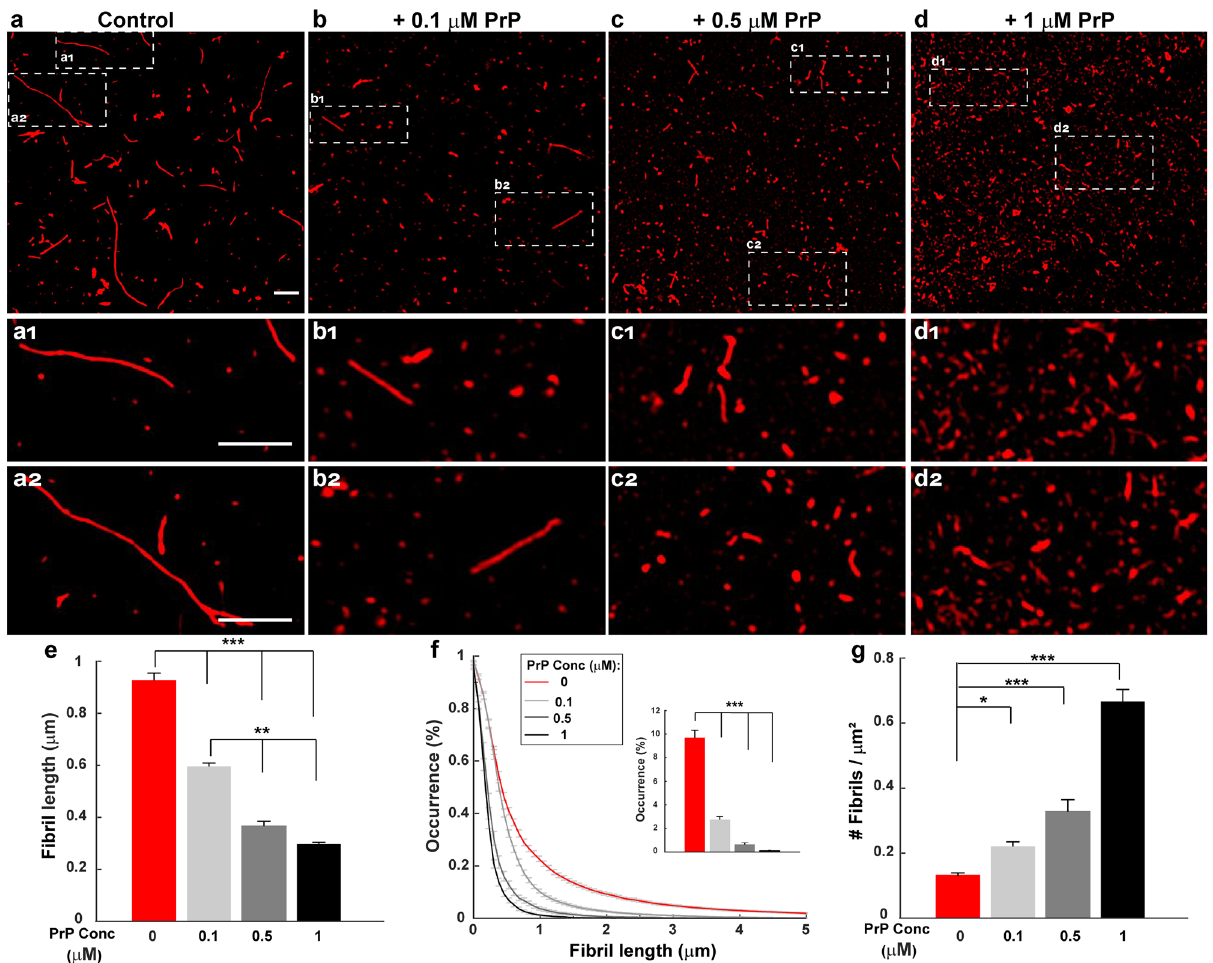
Fig. 1 PrP promotes formation of shorter, more numerous A β fi brils. A β -Cy5 monomer (20 µ M) was polymerized for 24 h in the presence of 0 µ M ( a ), 0.1 µ M ( b ), 0.5 µ M ( c ), or 1 µ M ( d ) PrP-AF555. Fibrils were then imaged by SIM. Panels a 1,2 – d 1,2 show boxed areas in ( a – d ), respectively, at higher magni fi cation. Scale bars are 1 µ m. e Bars show mean fi bril length at each PrP concentration. f Cumulative distributions of fi bril length at each PrP concentration. Inset indicates the number of fi brils larger than 2 µ m. g Bars indicate the number of detectable A β -Cy5 fi brils/ μ m 2 at each PrP concentration. Data represent mean ± S.E. * P < 0.05, ** P < 0.01 and *** P < 0.001 (two-sided Student ’ s t -test). The numbers of biological independent samples ( N ) and analyzed images ( X ) in each conditions are: Control: N = 9, X = 44; + 0.1 µ M PrP: N = 6, X = 22; + 0.5 µ M PrP: N = 10, X = 20; + 1 µ M PrP: N = 5, X =